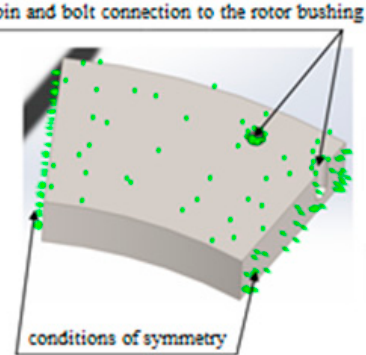
Figure 20. Conditions of the disc fastening.